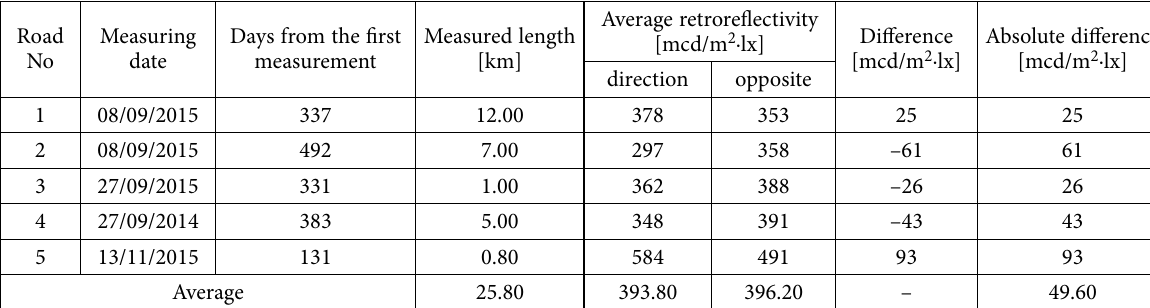
Table 6. Results of retroreflectivity measurement in the direction of